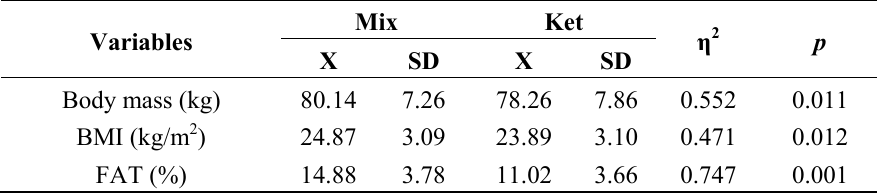
Table 3. Body mass and body composition in off-road cyclists after a mixed (Mix) and ketogenic (Ket)